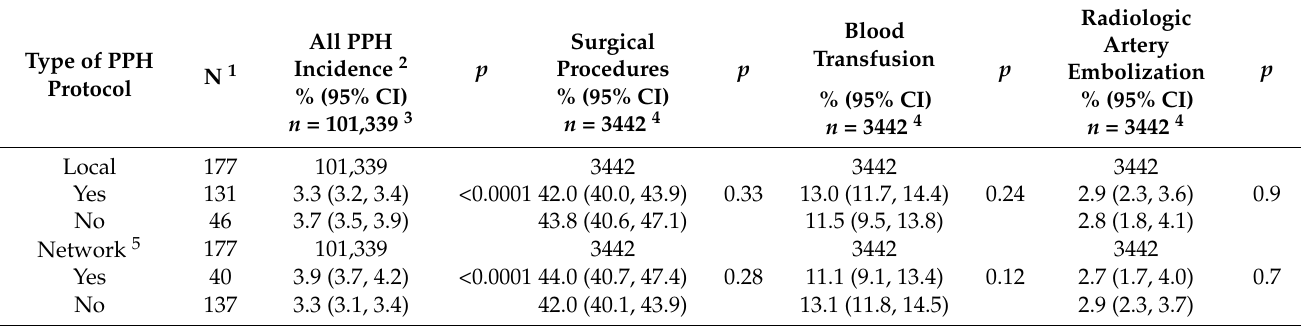
Table 3. Incidence of global PPH (>500 mL), transfusion of packed red blood cells, surgical procedures, artery embolization among women with a PPH, according to the presence of a local or perinatal network